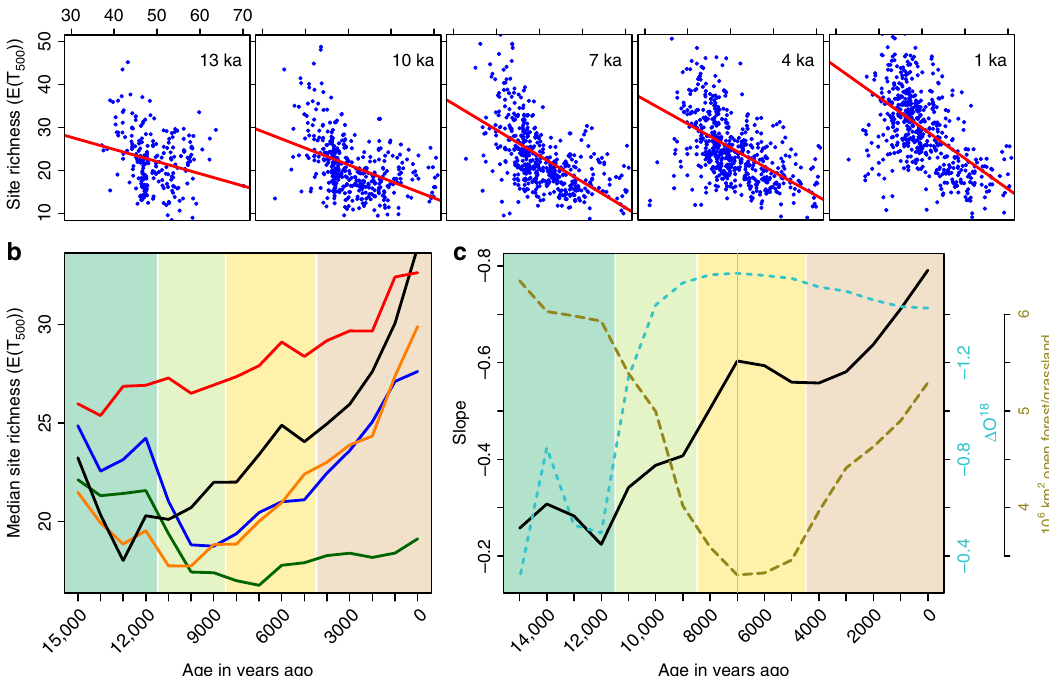
Fig. 2 Site-based changes in pollen type richness at a standardized sample size of 500 identi fi cations. a Scatter plots of pollen type richness versus latitude for selected time slices. b Median richness over all sites per region, colour coding as in Fig. 1. c Slope of the regression between pollen type richness and latitude of the site = black line; NGRIP Oxygen isotope record 28 resampled to the same resolution = light-blue broken line; area of partially open forests and grasslands in Europe taken from ref. 10 as a measure of landscape openness = brown broken